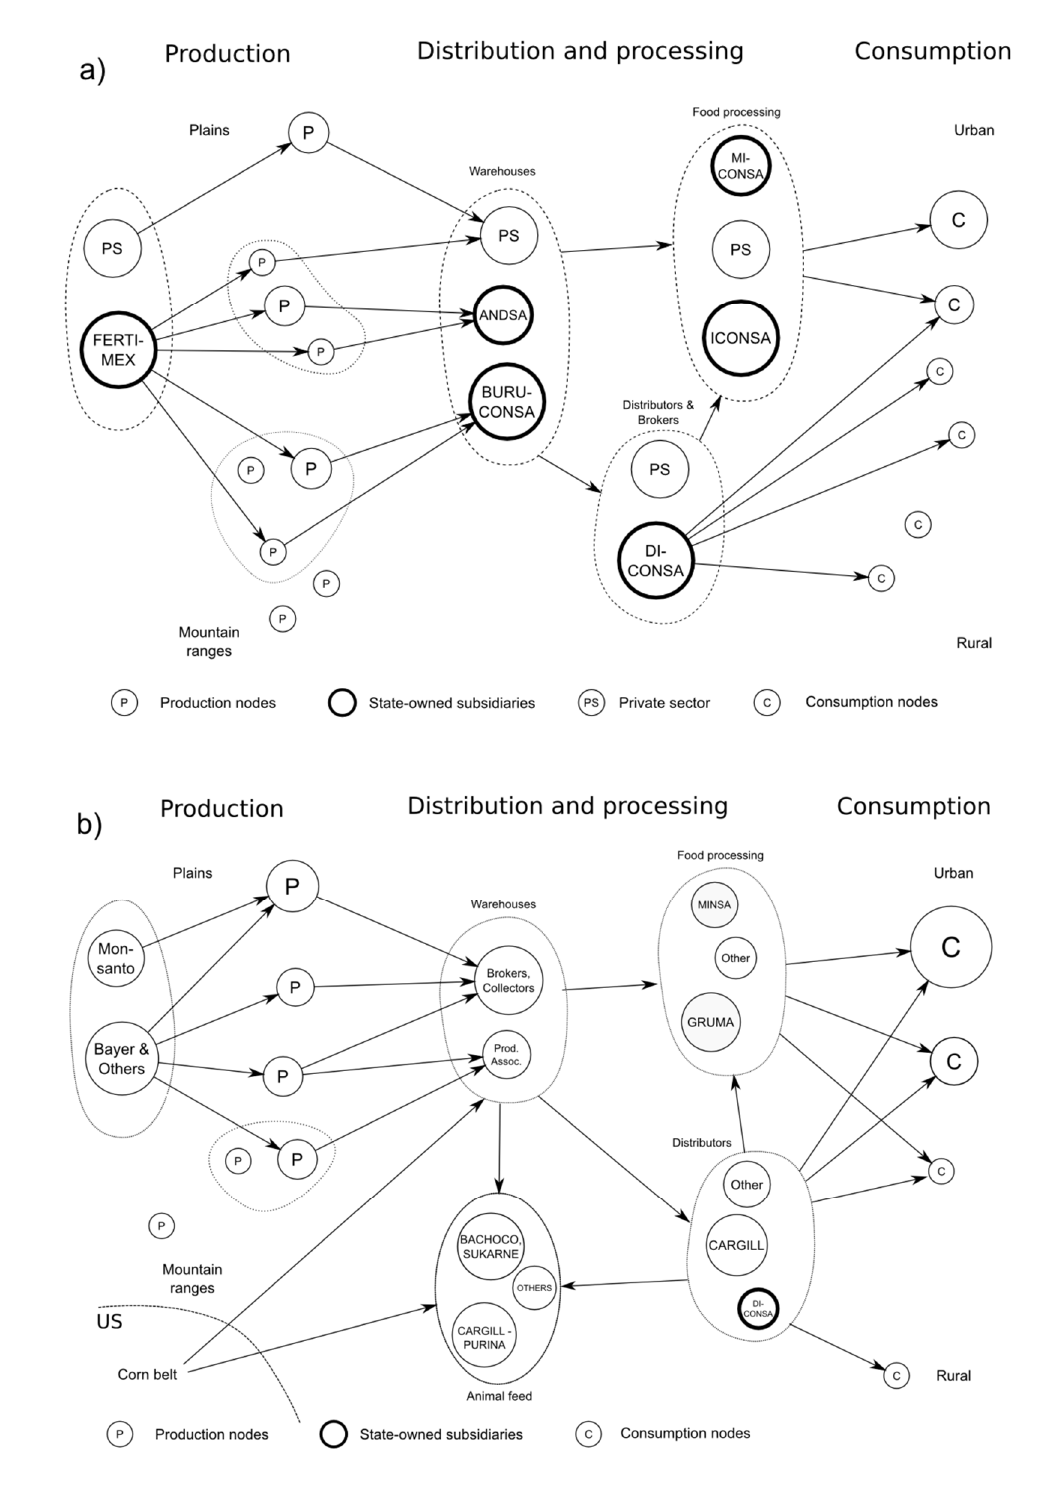
Figure 2. Maize IO production network structure. ( a ) Pre-reforms production network. ICONSA (Industrias CONASUPO S.A.), MICONSA (Maíz Industrializado S.A.), DICONSA (Distribuidora CONASUPO S.A.), ANDSA (Almacenes Nacionales de Depósito S.A.), BURUCONSA (Bodegas Rurales CONASUPO S.A.), FERTIMEX (Guanos y Fertilizantes de México S.A.). ( b ) Post-reforms production